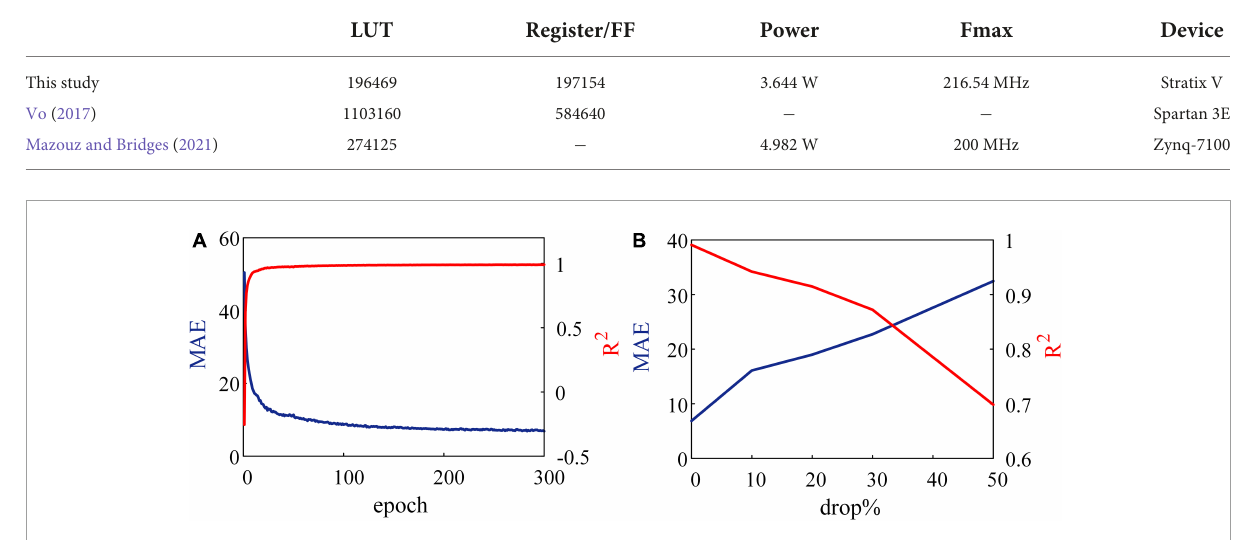
FIGURE8 Results of reproducing spike patterns. (A) Without noise, spiking neural network (SNN) reproduces input patterns accurately. (B) Noise in the form of dropping with a constant probability is added to an